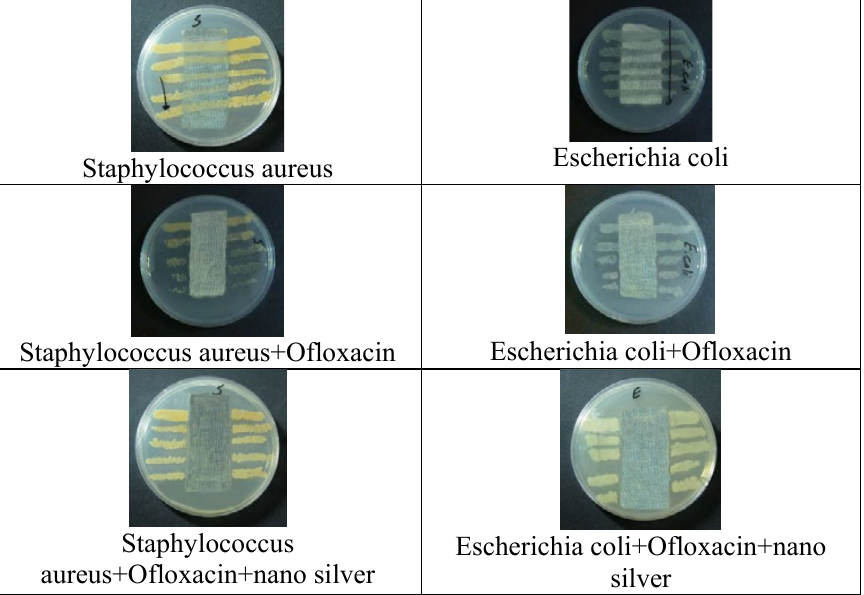
Fig. 5.1: Antibacterial assay of sterile gauze coated with Bassorin/PEO on S. aureus and E. Coli [, negative control- S. aureus , treated sample- S. aureus , negative control- E. Coli and treated sample- E. Coli ]